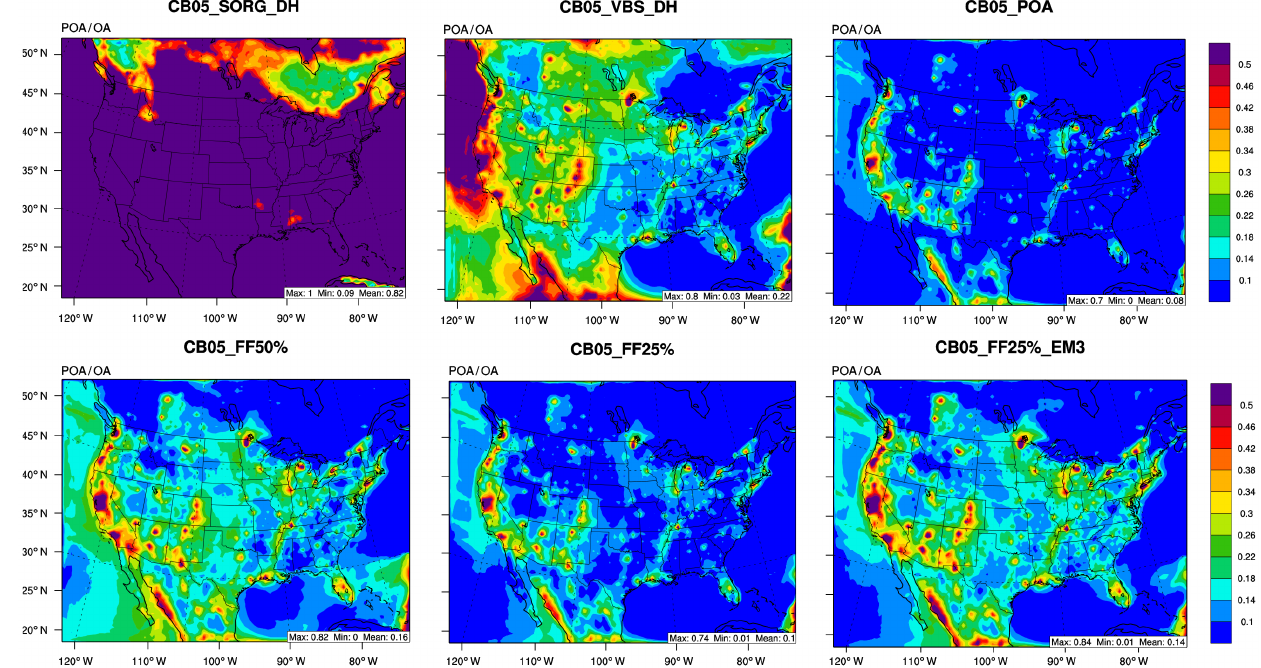
Figure 3. POA / OA ratios of sim data from various sensitivity simulation